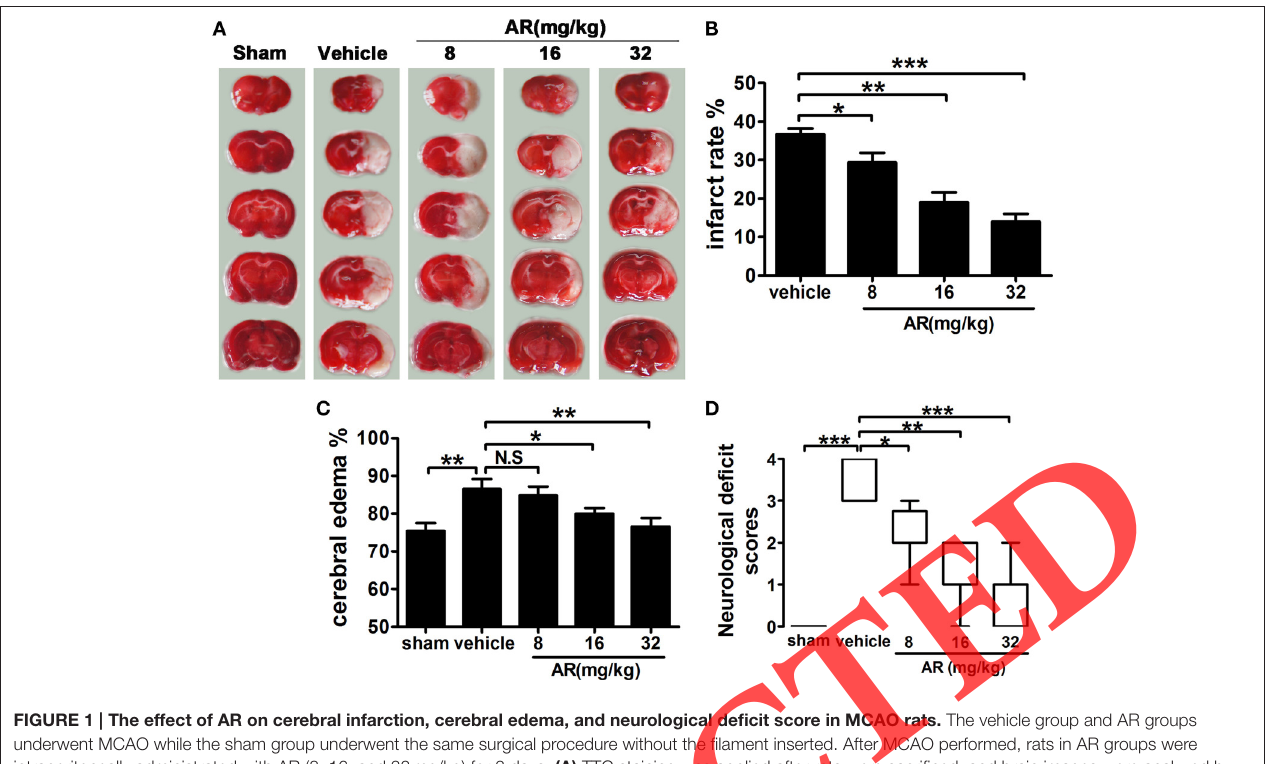
FIGURE 1 | The effect of AR on cerebral infarction, cerebral edema, and neurological deficit score in MCAO rats. The vehicle group and AR groups underwent MCAO while the sham group underwent the same surgical procedure without the filament inserted. After MCAO performed, rats in AR groups were intraperitoneally administrated with AR (8, 16, and 32mg/kg) for 3 days. (A) TTC staining was applied after rats were sacrificed, and brain images were analyzed by Image J software. And infarct area percentage data indicated in (B) were calculated as infarct area/whole area. (C) Cerebral edema was calculated as formula illustrated in the methods. (D) The neurological deficit evaluation were performed at 72h after reperfusion and analyzed with a Kruskal–Walls test followed by the Mann–Whitney U -test for multiple comparisons. Apart from neurological deficit scores, other data were presented as mean ± SD, neurological deficit scores were presented as median ( n = 8 ). * P < 0.05 ; ** P < 0.01 ; *** P < 0.001 . N.S, not